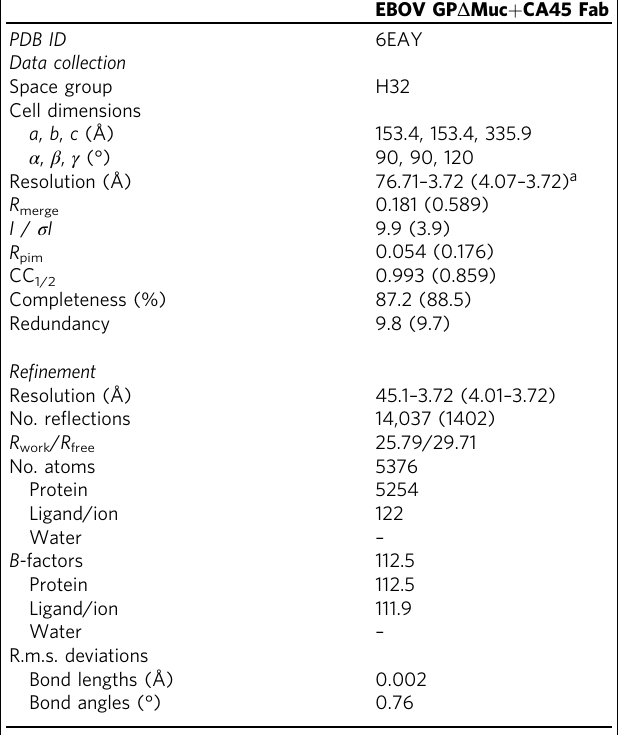
Table 1 Data collection and re fi nement